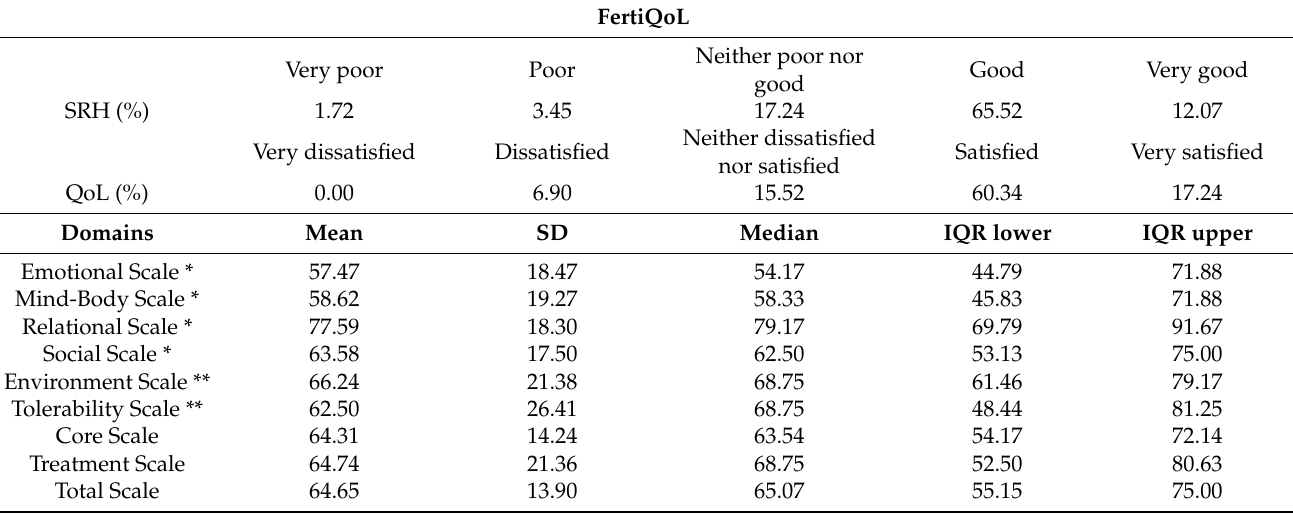
Table 3. Pre-treatment quality of life, mental status, and social support characteristics of women based on FertiQoL ( n = 60).